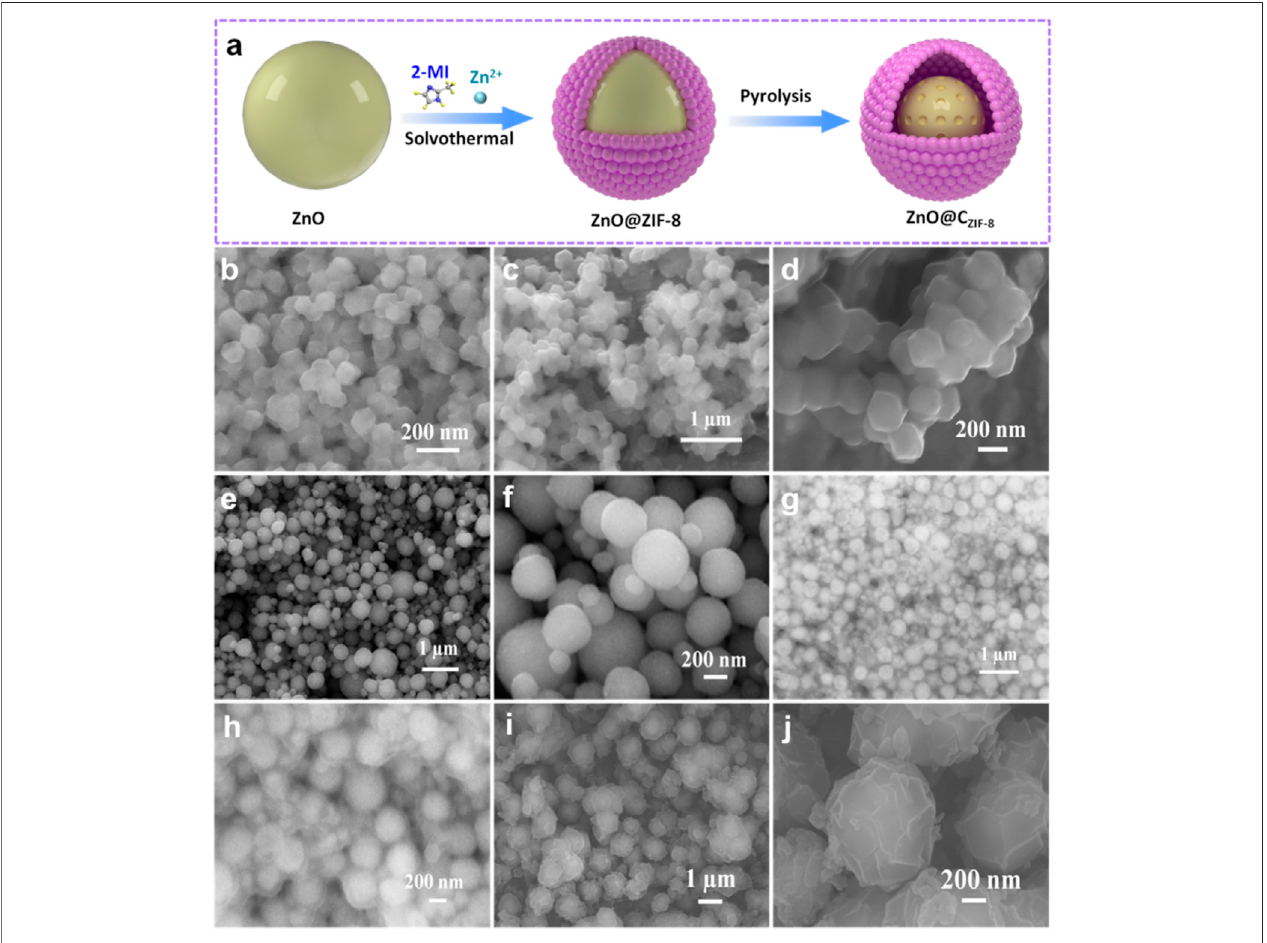
FIGURE1|(A) Thepreparationprocessofcore-shellZnO@C ZIF-8 .SEMimagesof (B) ZIF-8, (C,D) ZnO(ZIF-8), (E,F) ZnOnanosphere, (G,H) ZnO@ZIF-8,and (I,J) ZnO@C ZIF-8